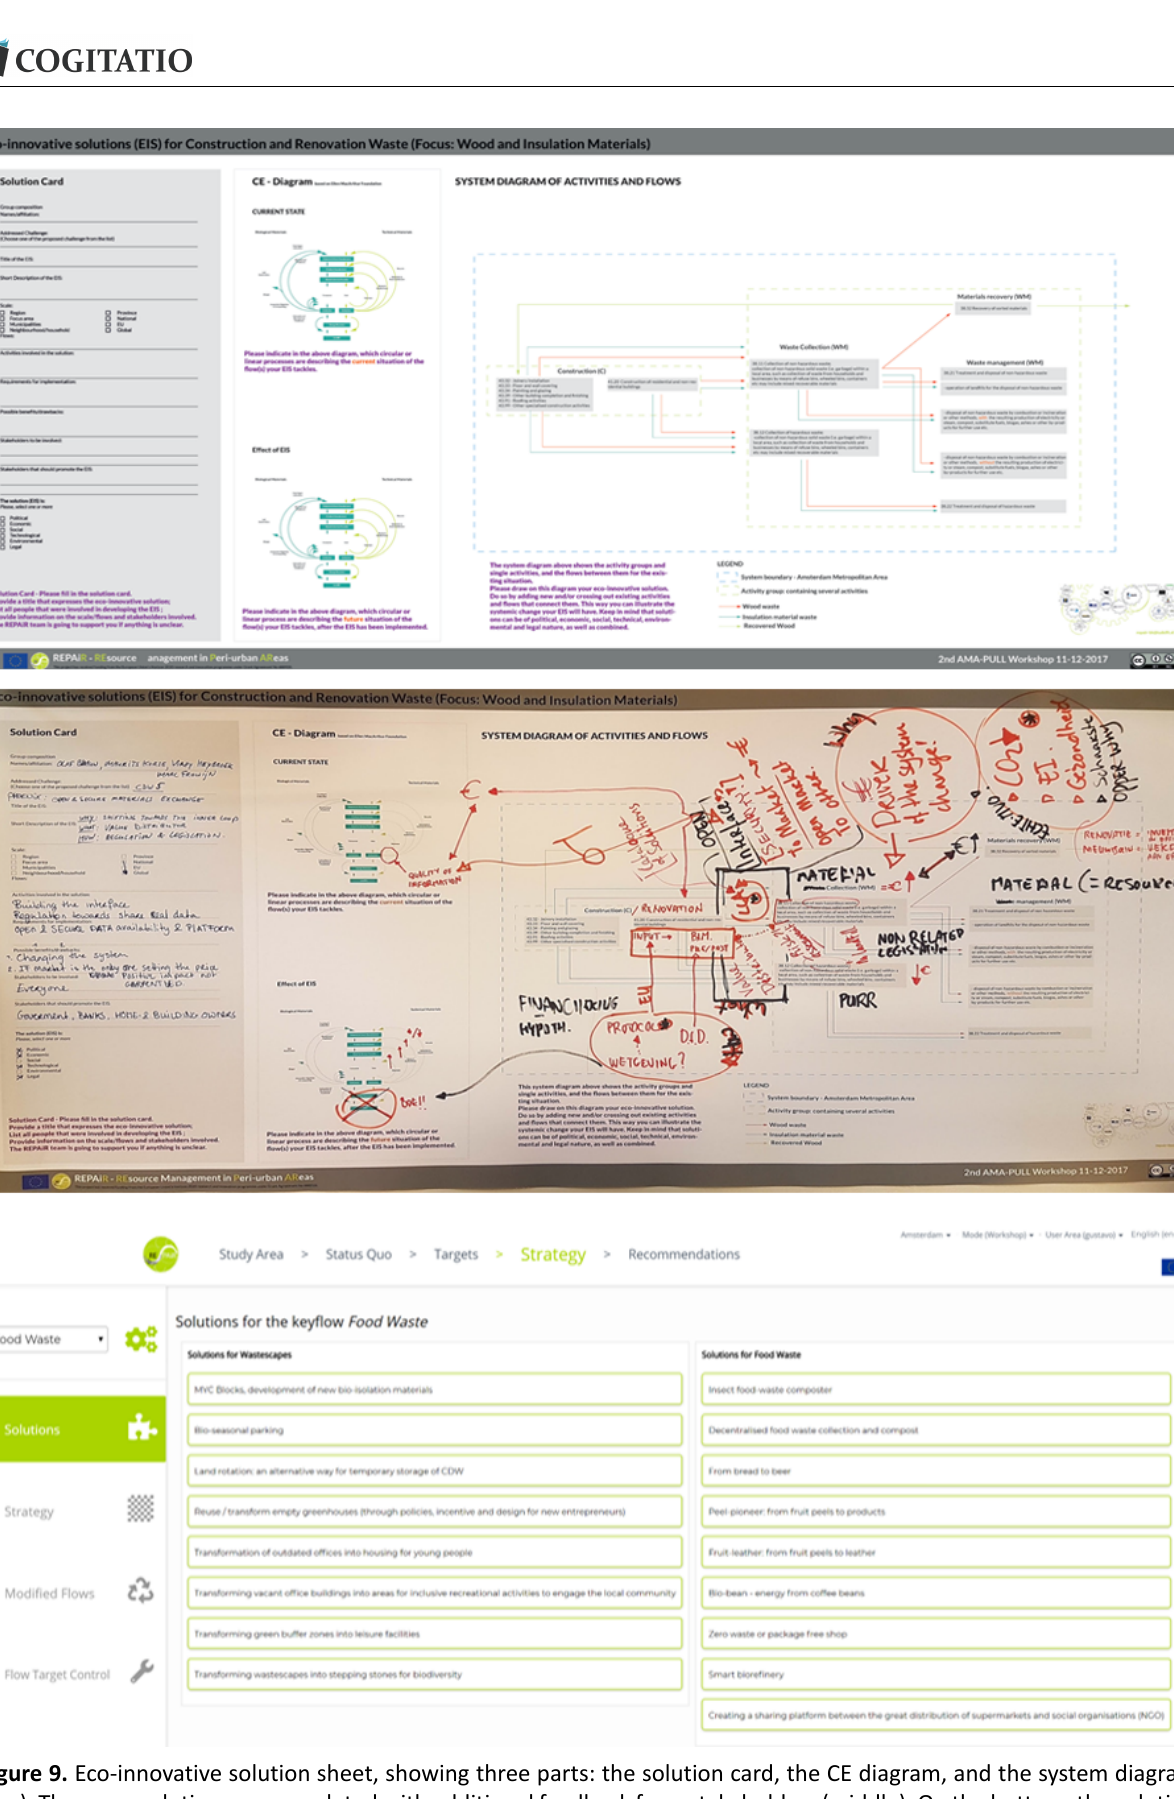
Figure 9. Eco-innovative solution sheet, showing three parts: the solution card, the CE diagram, and the system diagram (top). The same solution was completed with additional feedback from stakeholders (middle). On the bottom, the solution plus feedback was uploaded to the